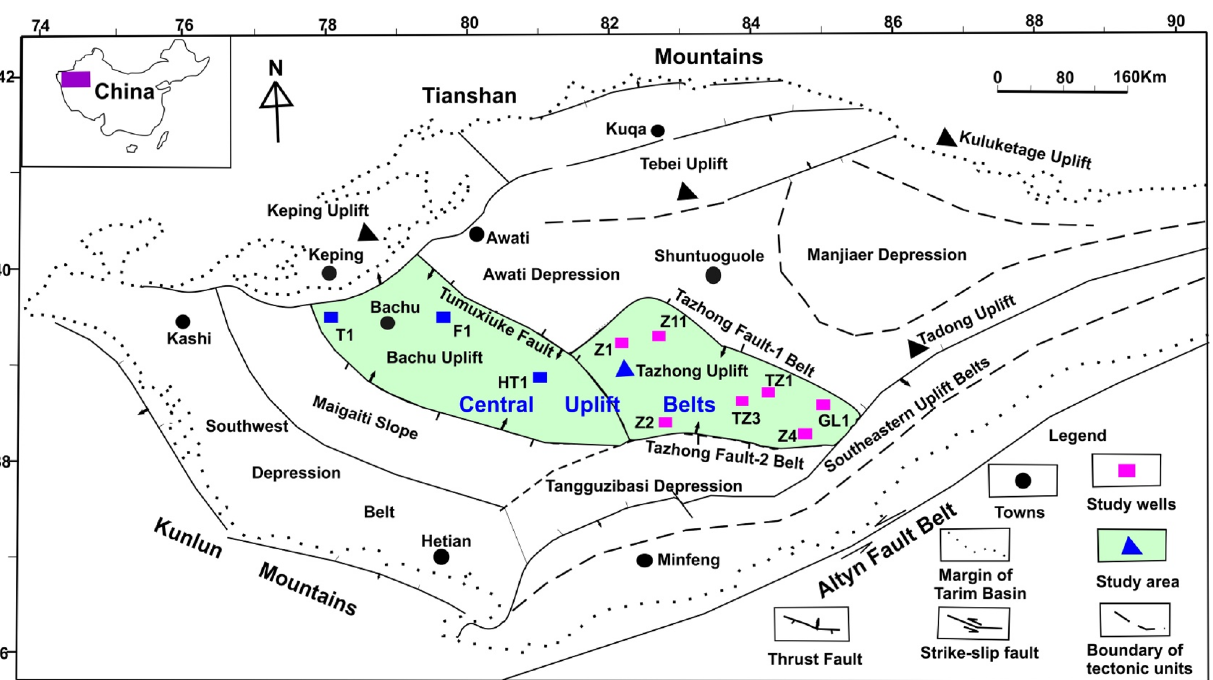
Fig. 1 A schematic tectonic map of the Tarim basin showing the distribution of structural units within the basin and the location of wells in the Tazhong (Katake) Uplift (Lin et al.